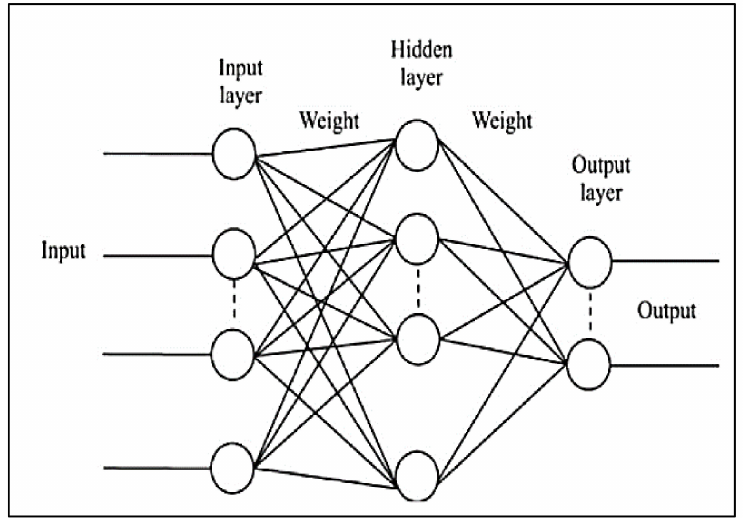
Figure 9. The structure of an ANN Adapted from B. Samantha